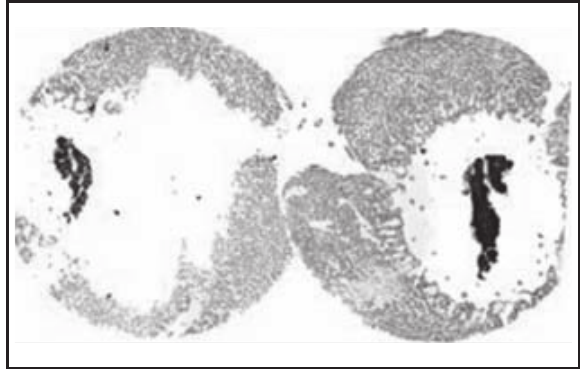
Figura 5 – Descolamentos centrais dos tecidos observados em algumas lâminas silanizadas